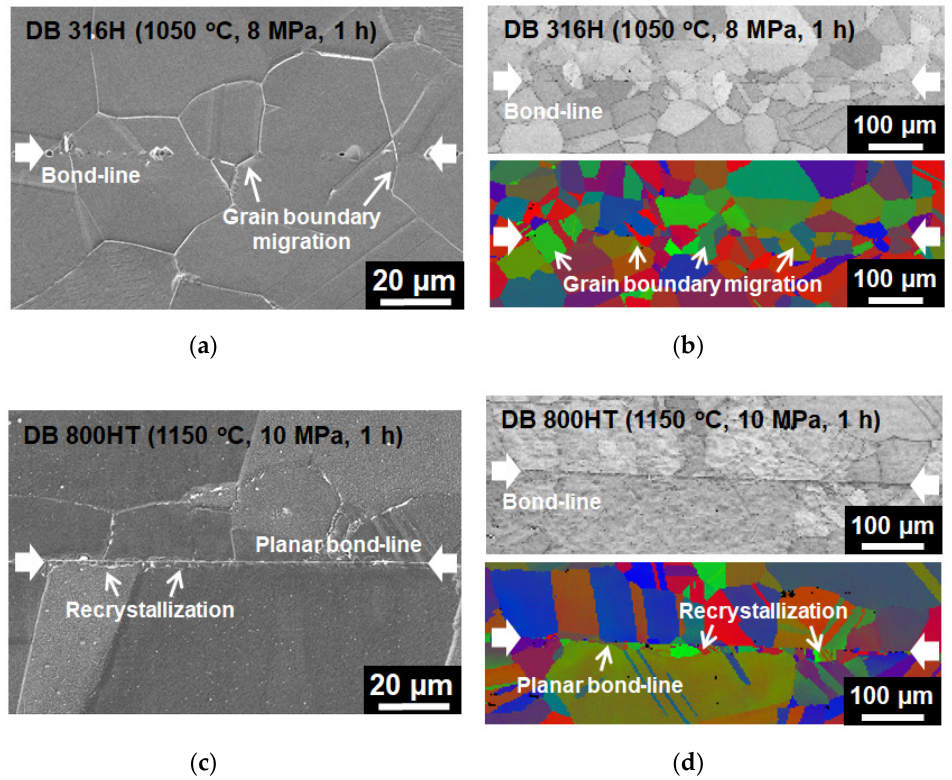
Figure 2. SEM micrographs of di ff usion bonded ( a ) SS 316H and ( c ) Alloy 800HT, and EBSD results of di ff usion bonded ( b ) SS 316H and ( d ) Alloy 800HT at the bond-line region.